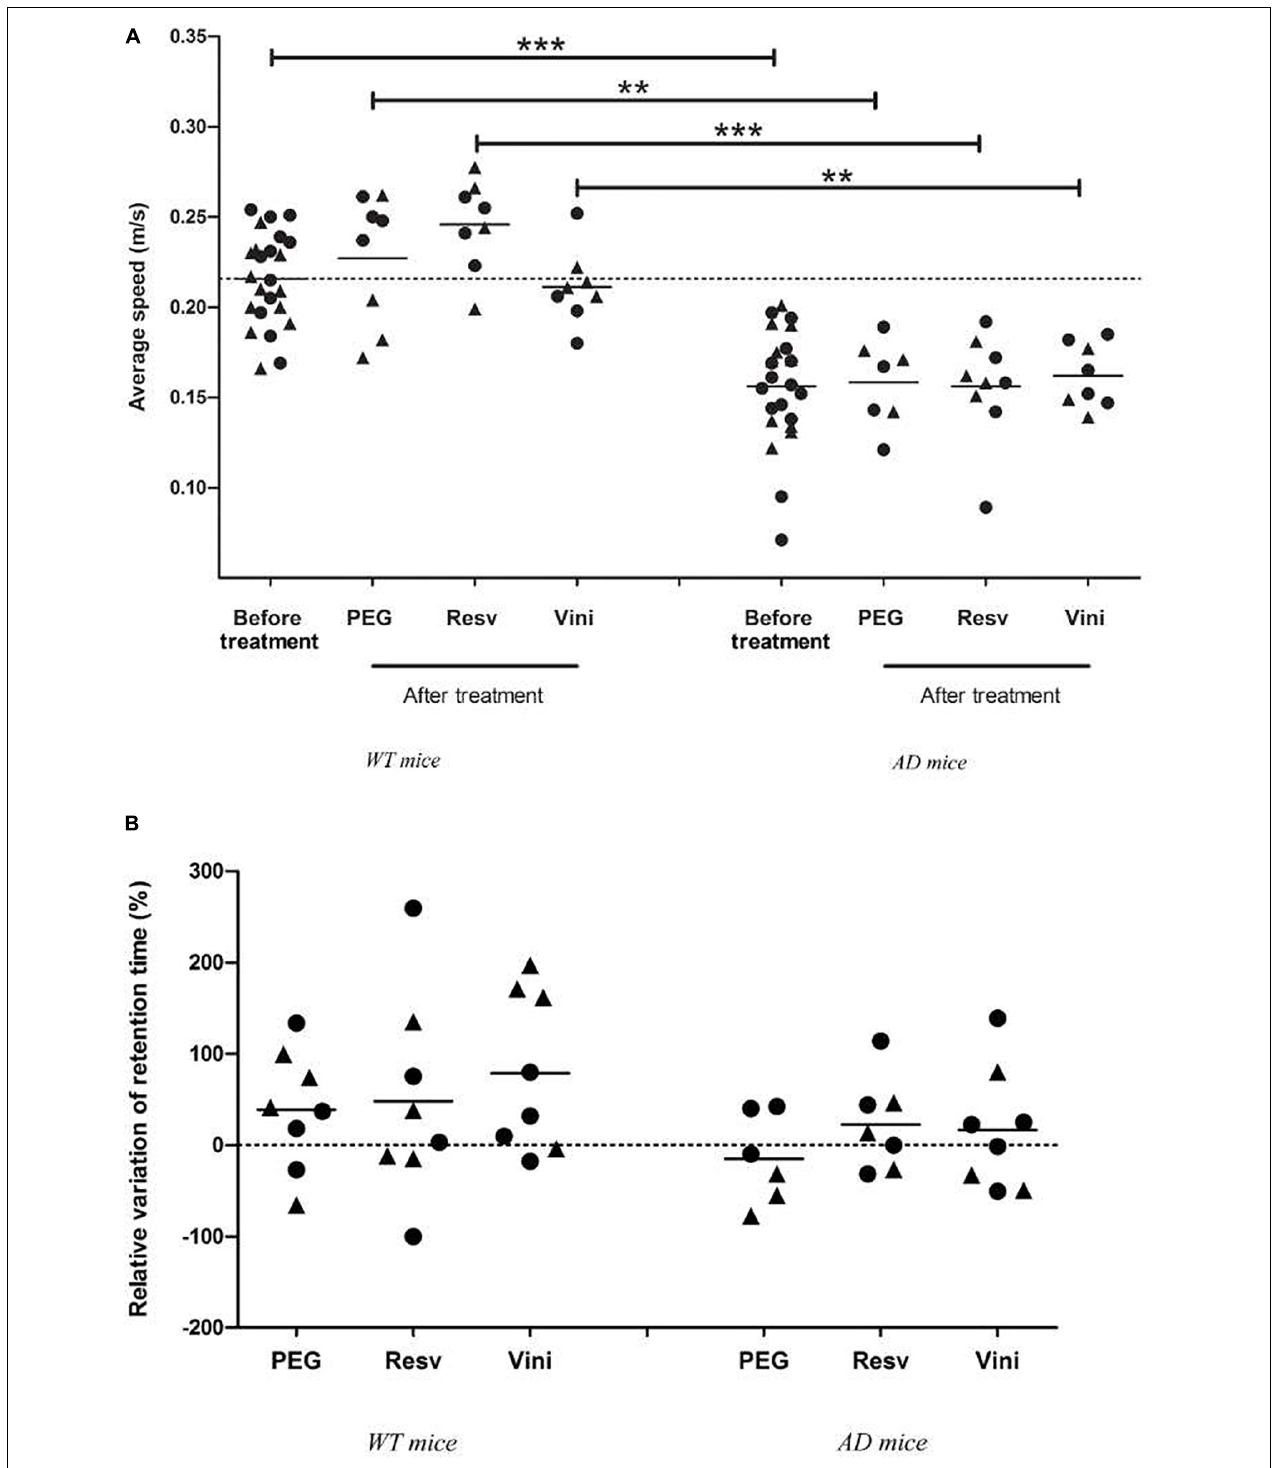
FIGURE 5 | Effects of resveratrol and viniferin on the motor capacities and memory decline. (A) The average speed of WT and AD mice was measured before and after treatment. (B) The relative variation of retention time expressed as percentage between the beginning and the end of treatment was quantified for WT and AD mice. To compare values of average speed and relative variation of retention time, the Mann–Whitney test was used ( n = 7–24). *** p < 0.001, ** p < 0.01, compared to each treatment between WT and AD treated mice. The dotted line represents the mean of average speed before treatment (panel A) and sets at 0 for relative variation of retention time (panel B). Black rounds represent females and black triangles represent